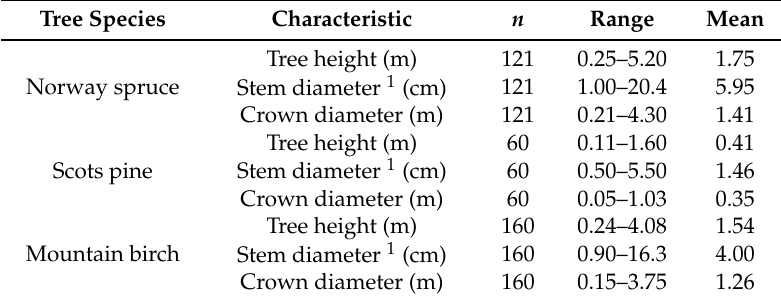
Table 1. Summary of field measurements of trees.